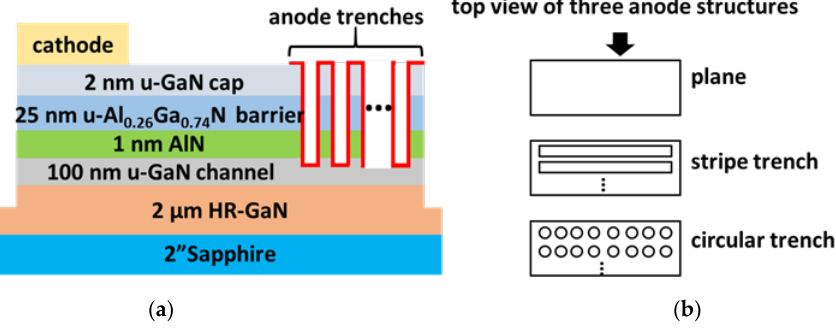
Figure 1. ( a ) schematic view of fabricated Schottky barrier diodes ( SBD ) with one type of the anode trenches; ( b ) the top view of three anode geometries, and the number of rows is changed from 1 to 4.